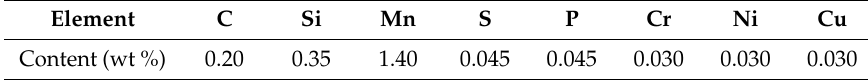
Table 2. The chemical compositions of the steel strips.